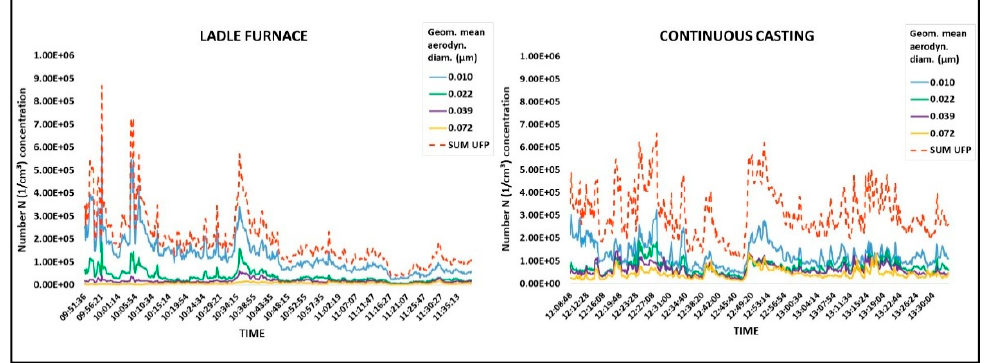
Figure 4. Time variation of ultrafine particle (UFP) number concentrations (part/cm 3 ) by size measured by ELPI next to ladle furnace and continuous casting. x -axis represents sampling (hh:mm:ss) and y -axis represents UFP number concentration (1/cm 3 ).